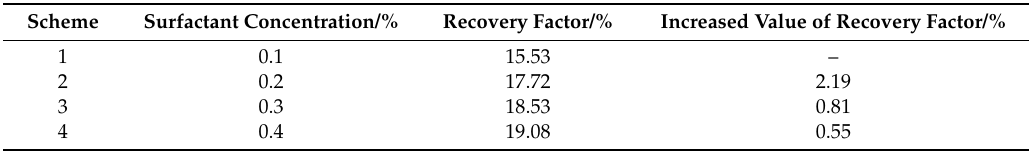
Table 3. Recovery factor percentage of different experimental